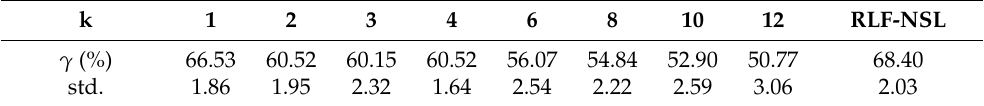
Table A1. The classification accuracy γ and the standard deviation (std.) on the MNIST dataset for N = 6 by KNN with different k and by the RLF-NSL with β = 1.08.